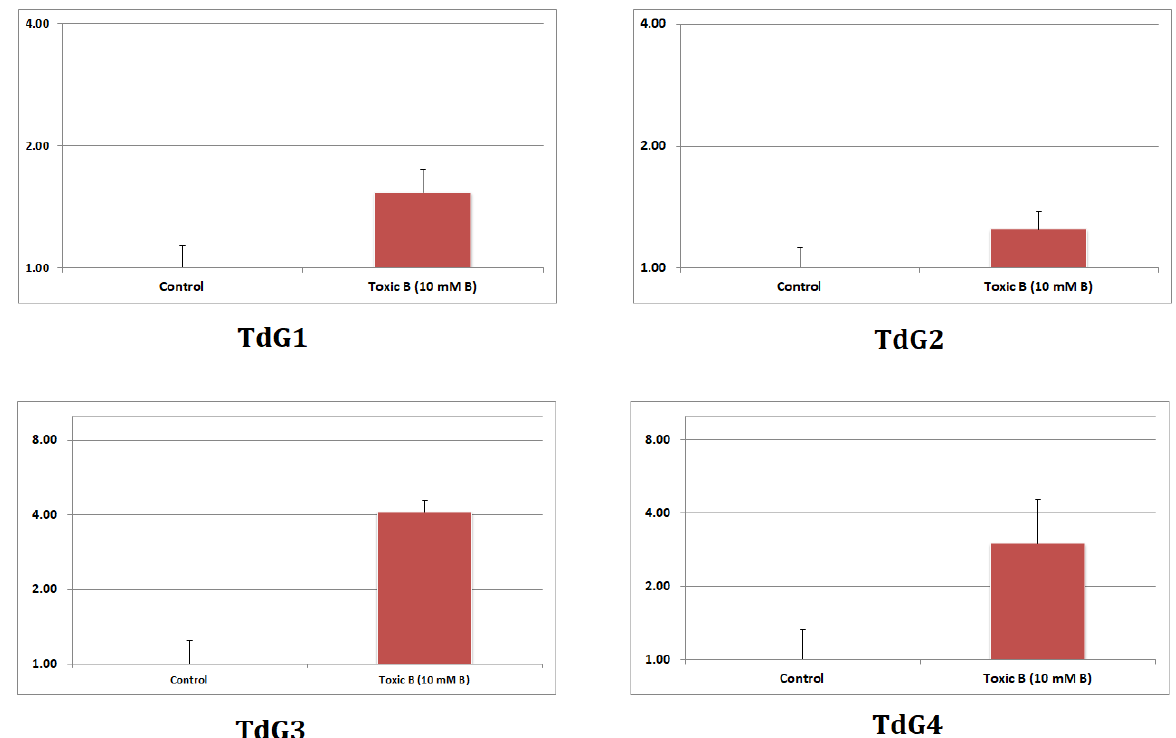
Figure 5. Relative expression of TdG1 (TraesCS3B02G001500), TdG2 (TraesCS3B02G252900), TdG3 (TraesCS3B02G191500) and TdG4 (TraesCS3B02G388100) of high-B (TB 10 mM)-treated shoots of the T. dicoccum (Td) genotype, PI94655 compared to 3.1 µM B (control) treatment in relation to the reference gene, TaGAP. The values are provided as average expression of three individual replicates with standard error mean normalized to control.